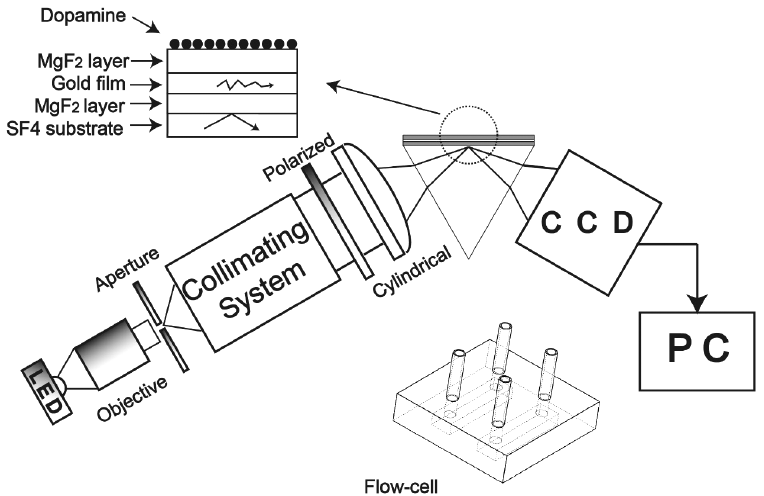
Fig. 2. Schematic of our SPR imaging system and °ow